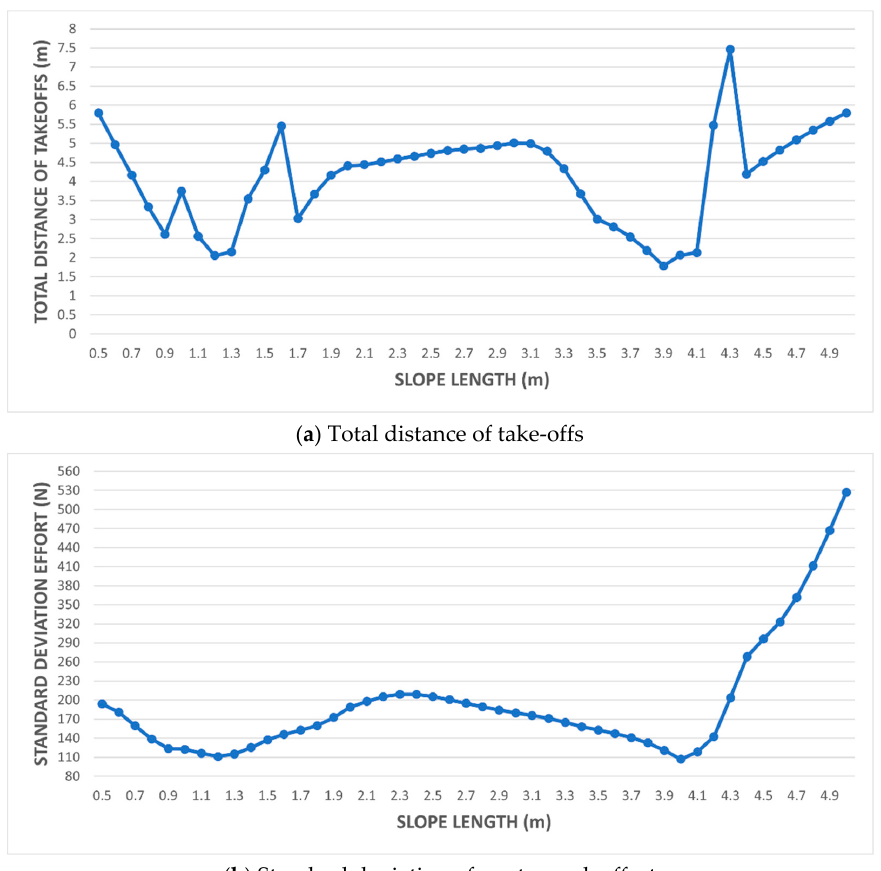
Figure 15. Graphs at total distance take-offs ( a ) and standard deviation ( b ) when the train is circulating at a speed of 200 km/h.